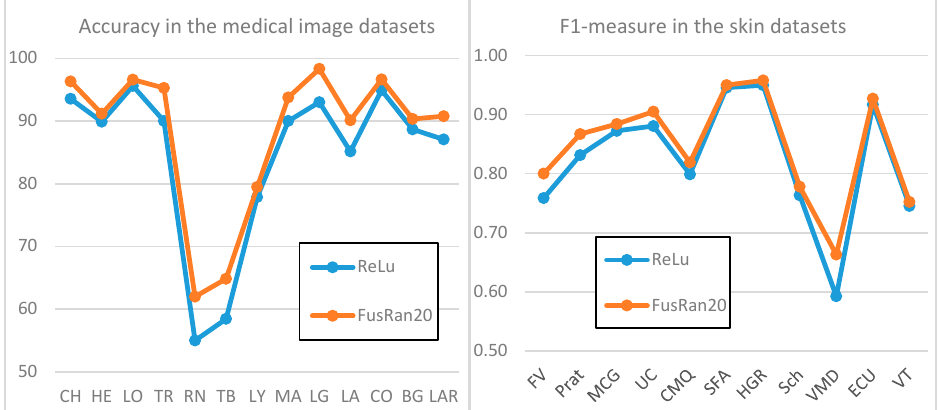
Figure 2. Comparison among the baseline ReLU and the ensemble FusRan20 in both the problems.